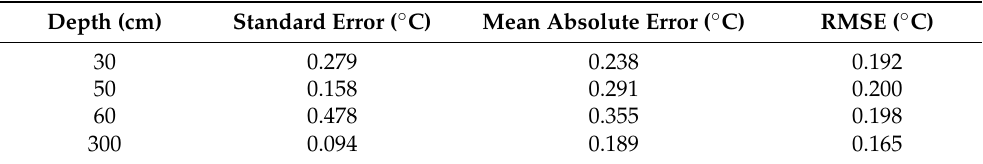
Figure 16. Comparison of the MAGT values and the subsurface temperatures estimated by the TLZ model for the period 2012 – 2021 for depths of ( a ) 30 cm, ( b ) 50 cm, ( c ) 60 cm, and ( d ) 300 cm. Table 2. Standard error, mean absolute error, and RMSE of subsurface temperatures by the TLZ model for depths of 30, 50, 60, and 300 cm, with reference to MAGT-based values. Depth (cm) Standard Error (°C) Mean Absolute Error (°C)